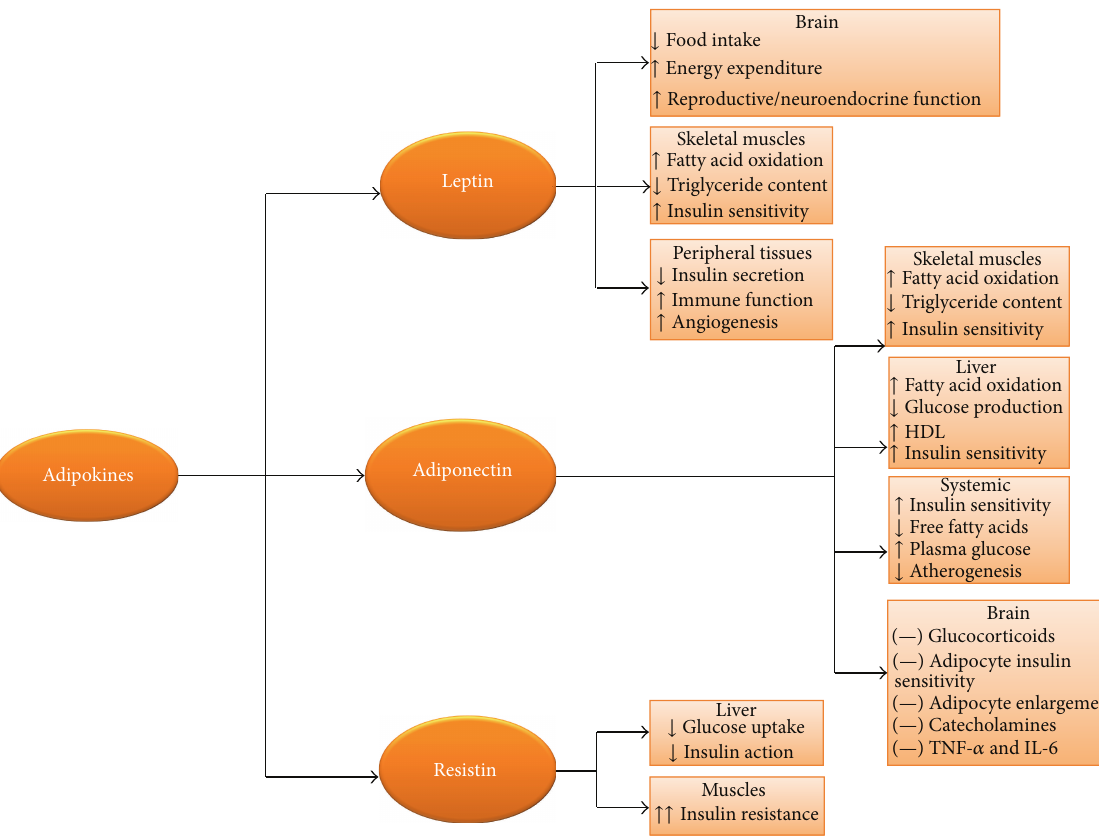
Figure 1: Selected physiologic roles of adipokines in relation to glucose metabolism and insulin sensitivity ( ↑ increase, ↓ decrease, (—) inhibit).